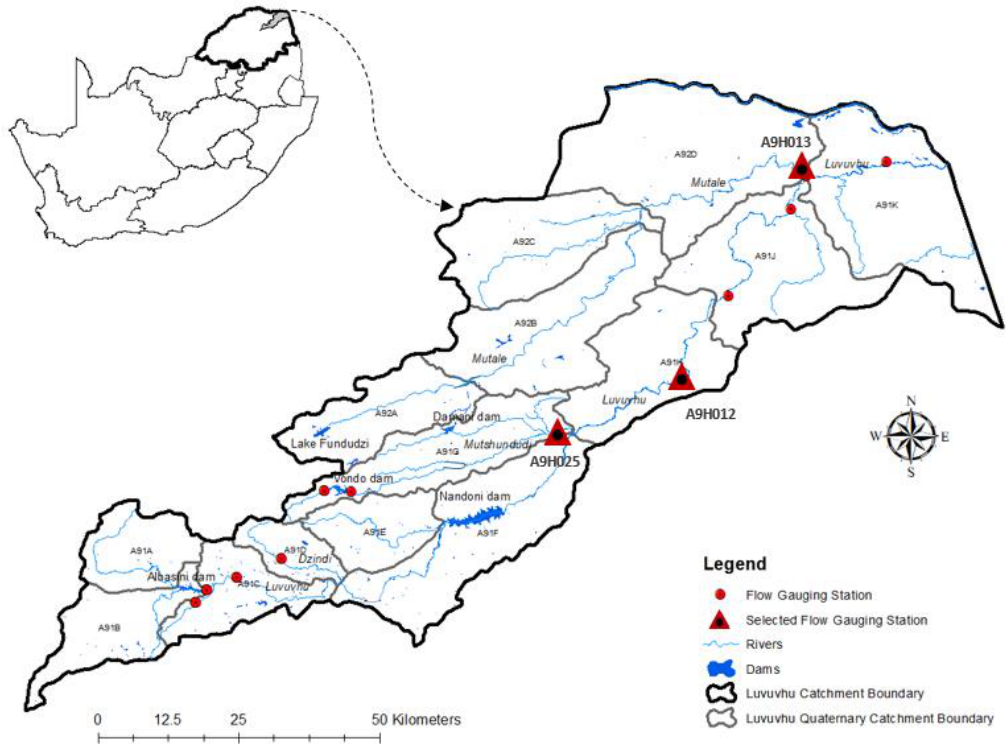
Figure 1. Map of the Luvuvhu River catchment highlighting the major dams, gauging stations and quaternary catchments.